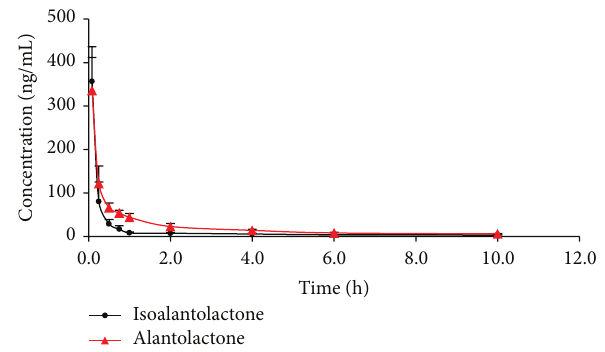
Figure 3: Mean ± SD plasma concentration-time profiles of isoalantolactone and alantolactone in rat plasma following i.v. administration at 5 mg/kg dose,